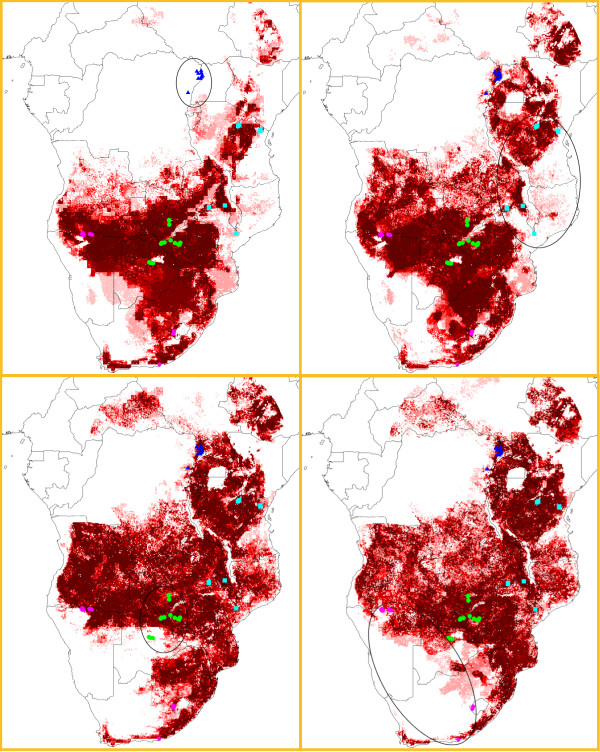
Potential plague distribution predictions based on regional subsets. Potential plague distribution predictions were based on all environmental coverages and 3 regional subsets of occurrence points in sub-Saharan Africa. Independent test points from fourth subset are surrounded by a black oval. Dark shades indicate areas with greater model agreement in predicting area as suitable for plague; upper left, subsets B, C and D predict A; upper right, subsets A, C and D predict B; bottom left, subsets A, B and D predict C; and bottom right, subsets A, B, C predict D.